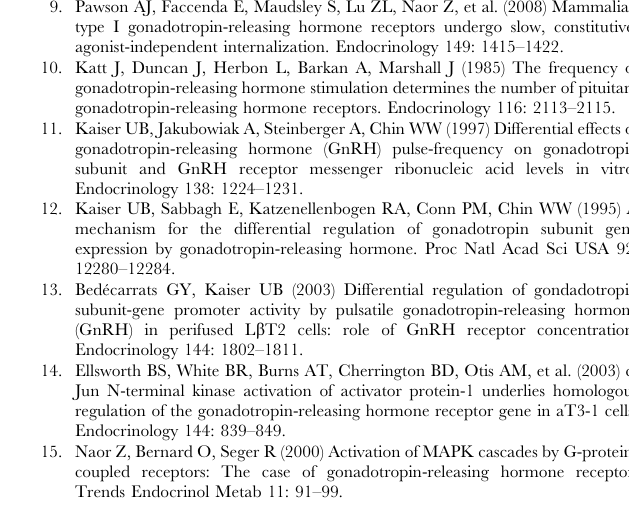
Table S1 Glossary of variables for the basic model Table S3 Glossary of new variables for the intermediate and full Table S4 Additional constants for the intermediate and full Figure S1 Sensitivity analysis of the basic model. The basic model was simulated for 1440 min with five different frequencies of the exponential pulse profile of MAPKK: 8 min, 30 min, 60 min, 120 min and 240 min. Thereafter, each kinetic constant was varied by 10%, in turn, to visualize the effects of such fluctations to the overall frequency decoding ability of the system. Fold-differences of the accumulated concentrations for each subunit gene were then plotted. Only results for the kinetic constant, kcat1, have been shown here. Figure S2 Sensitivity analysis of the expanded model without receptor dynamics. The expanded model without receptor dynamics, but with the inclusion of ERK5, was simulated for 1440 min with five different frequencies of the exponential pulse profile of MAPKK: 8 min, 30 min, 60 min, 120 min and 240 min. Thereafter, each kinetic constant related to ERK5 was varied by 10%, in turn, to visualize the effects of such fluctations to the overall frequency-decoding ability of the system. Fold- differences of the accumulated concentrations for each subunit- gene were then plotted. Only results for the kinetic constant, kcat1, have been shown here.